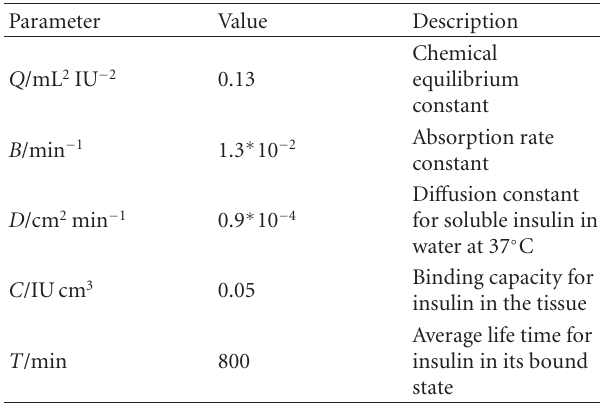
Table 2: Parameter set derived from Mosekilde et al.